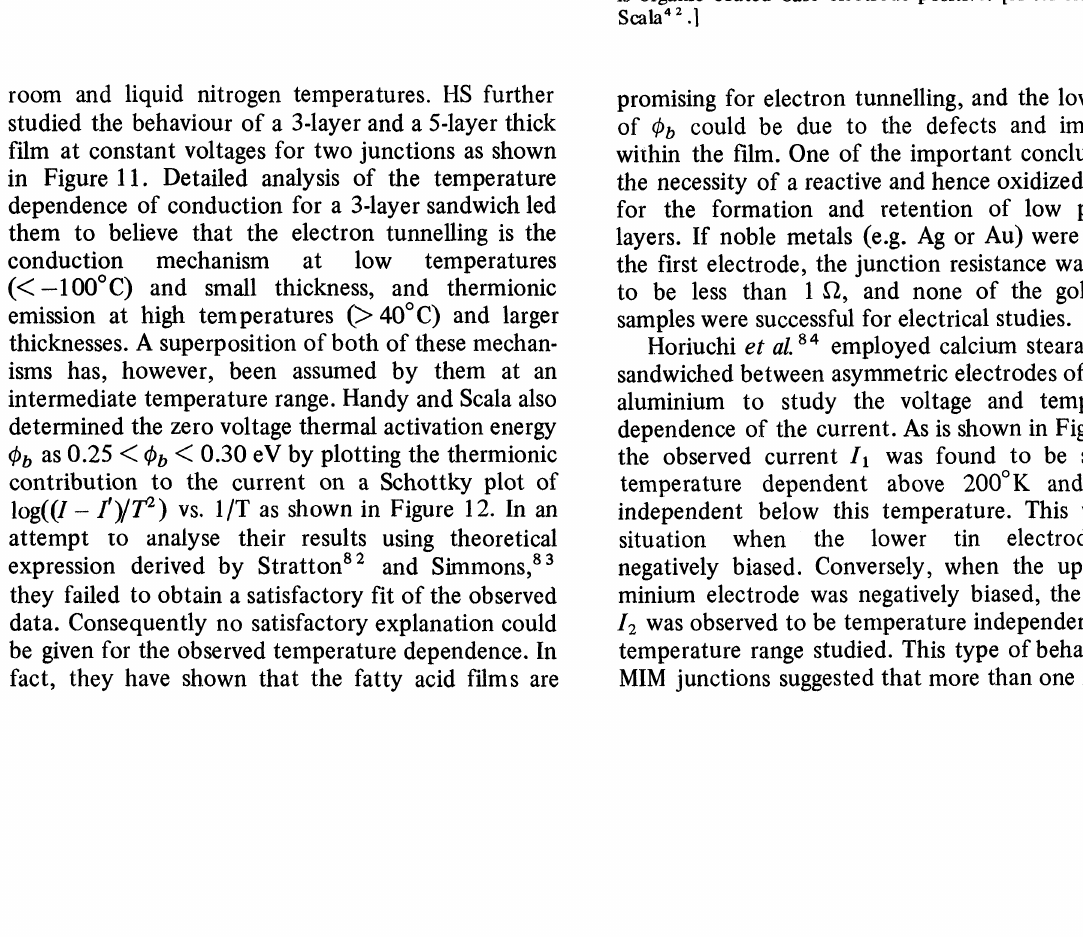
FIGURE 10 Current-voltage characteristics at 0.1 Hz of Sn 3 layer calcium stearate-Sn sandwich of lmm area at room and liquid nitrogen temperatures. Polarity is that of organic coated tin base layer. [After Handy and Scala 42 .]